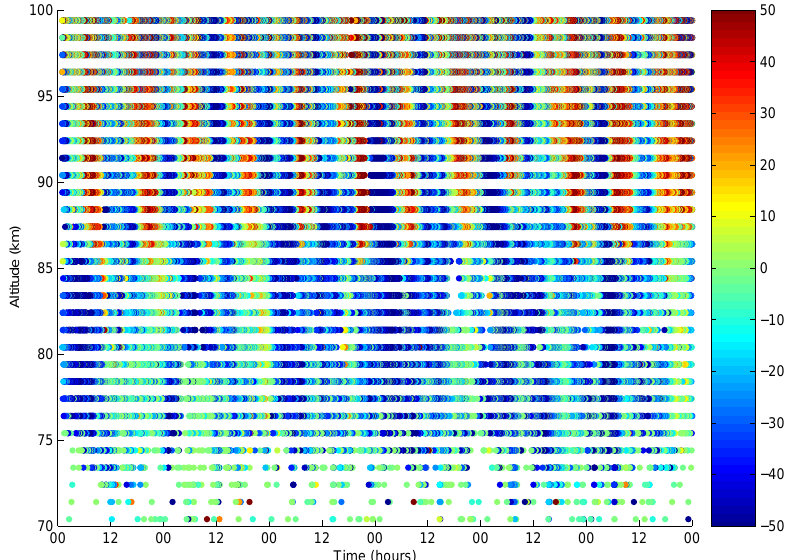
Fig. 1. Time-altitude contour plot of the zonal wind (ms − 1 ) observed by the Scott Base MF radar during the 1 to 6 January